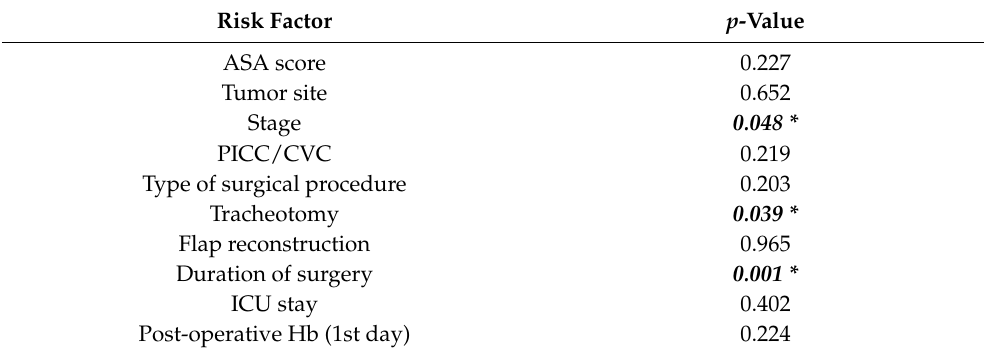
Table 6. Multivariate analysis regarding risk factors for post-operative infection (all sites).